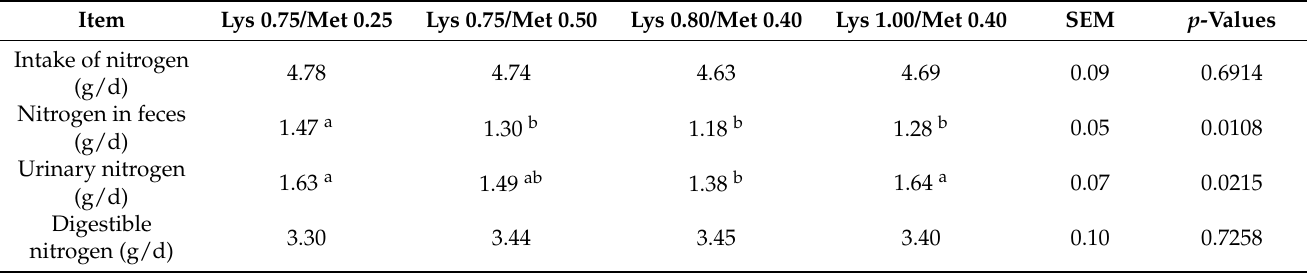
Table 2. Effect of different lysine and methionine composition in diets on nitrogen metabolism in rabbits ( n =